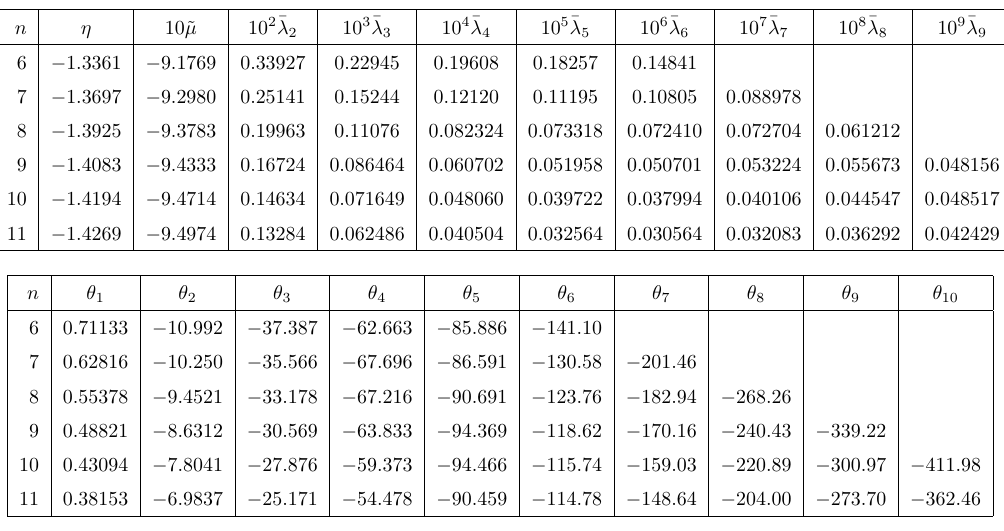
Table 3 . Values of the coupling constants and scaling exponents of the NGFP 1 in the large- N k regime for r crit = d crit + 1 = 5 (for ζ = 1 ) in ( ¯ ϕϕ ) n truncation of the LPA 0